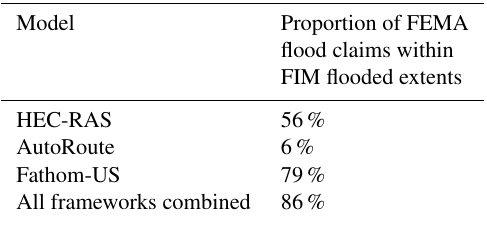
Table 5. Proportion of FEMA insurance claims within the FIM for a combination of all three FIM modeling